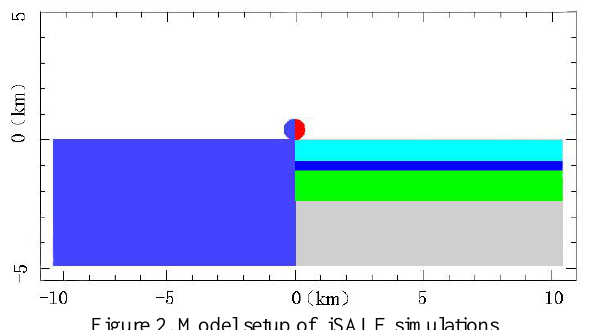
Figure 2. Model setup of iSALE